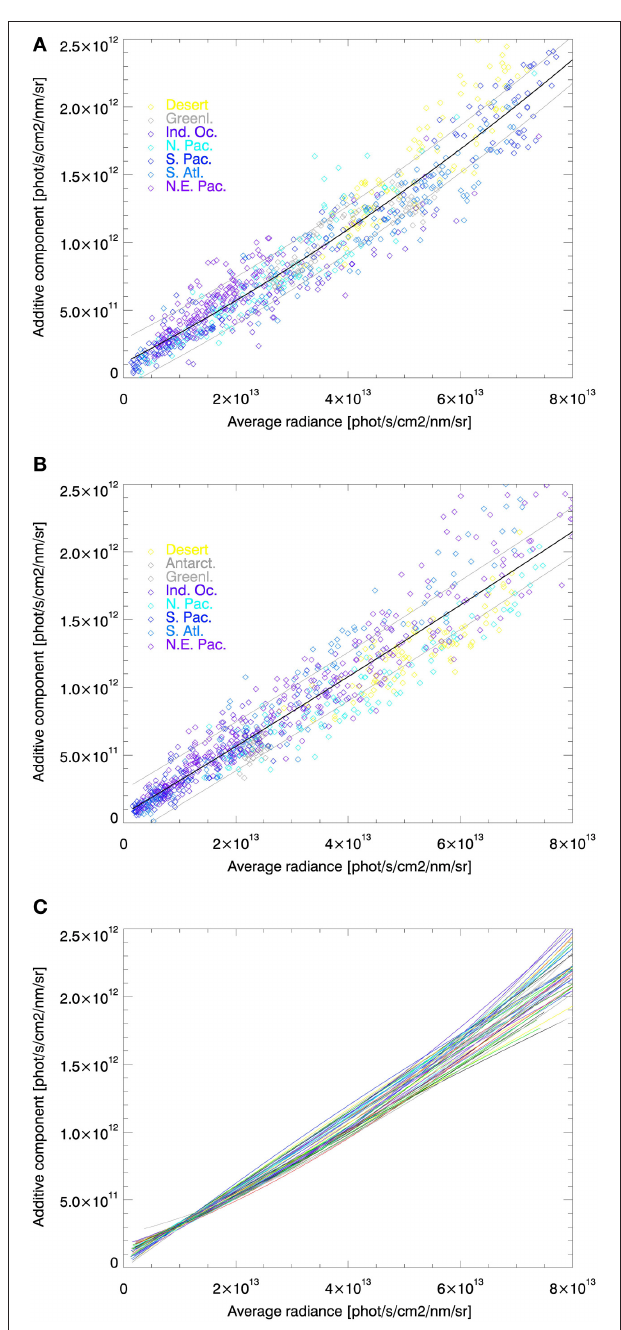
FIGURE 4 | Dependence of the additive radiance component ε a on the average radiance in the fit window, ¯ I m , for one day of data for regions shown in Figure 3. (A) On September 9th, 2008; (B) On March 1st, 2008; (C) All fitted results for 2008- one line per day. The average slope (parameter b in Equation 17) is located at 0.02 and is well confined with ± 0.01.